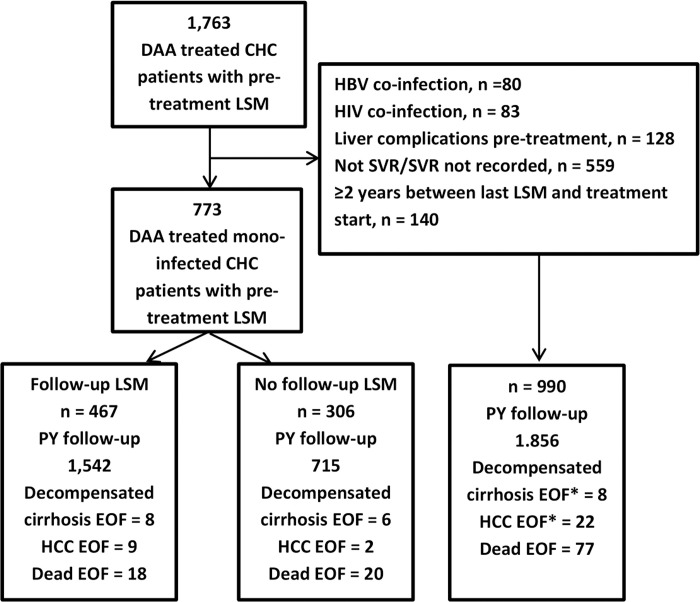
Flow chart for inclusion.Abbreviations: DAA; direct-acting antivirals, CHC; chronic hepatitis C, LSM; liver stiffness measurement, HBV; hepatitis B virus, HIV; human immunodeficiency virus, PY; person-years, EOF; end of follow-up. * First episode.